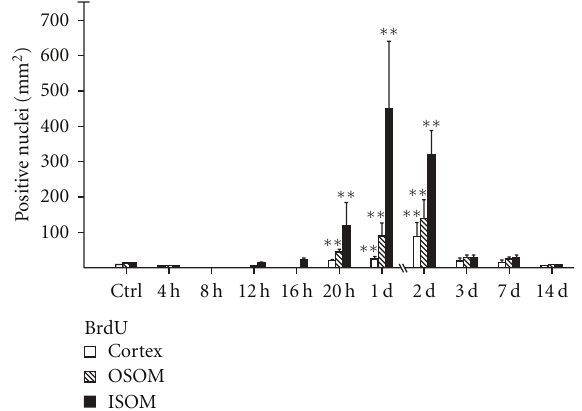
Figure 1: Density of S-phase fusiform interstitial cells evidenced by BrdU incorporation in cortex and outer medulla (OSOM, ISOM) of kidneys from control animals (Ctrl) or from animals sacrificed at increasing times (hours or days) after reperfusion. BrdU was administered to experimental animals 1hour before sacrifice. Each column corresponds to the mean number of labeled nuclei per mm 2 ( ± SD) determined after examination of each region of the kidney for each experimental group ( n = 4) ( ∗∗ P < . 01 versus